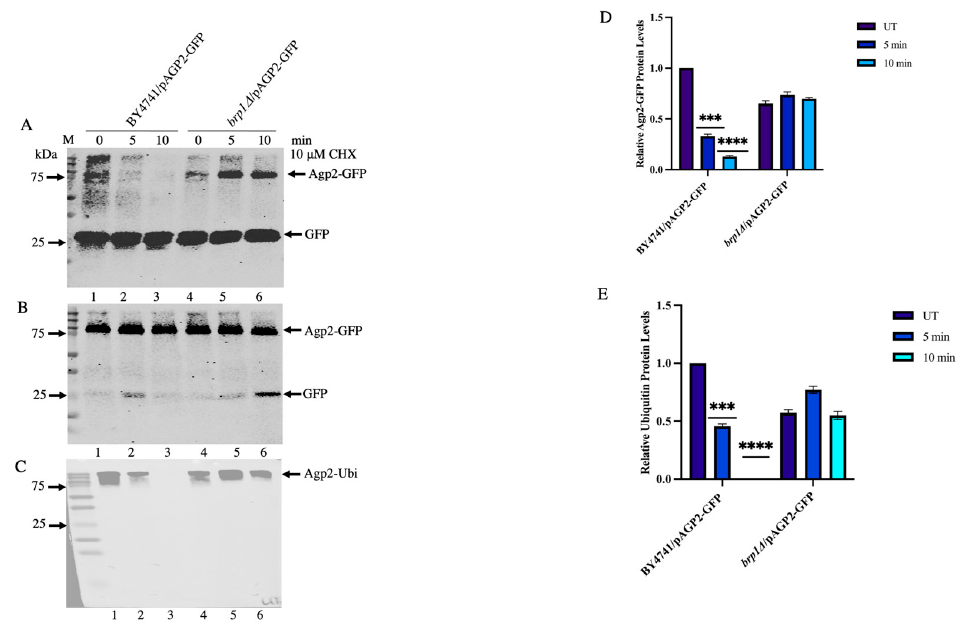
Figure 8. Analysis of immunoprecipitated Agp2-GFP from saturated cultures of the WT and the brp1 ∆ mutant. ( A ) Immunoprecipitation of Agp2-GFP showing its disappearance in the WT and not in the brp1 ∆ mutant following CHX treatment. Briefly, total extracts were prepared from saturated cultures treated with CHX, subjected to pull-down assay using anti-GFP magnetic beads and probed by immunoblot with anti-GFP antibodies. ( B ) Total cell extracts were used to monitor the input level of Agp2-GFP. ( C ) The same amount of the pull-down samples from panel ( A ) were analyzed by immunoblot probed with anti-ubiquitin antibodies. ( D , E ) Quantification of the relative level of the immunoprecipitated Agp2-GFP under the indicated conditions from panels ( A , C ), respectively. M, prestained protein markers in kDa. Error bars indicate S.E. The data are representative of three biological replicates and analyzed by 2-way Anova Test. *** Is equivalent to p -value < 0.001, **** Is equivalent to p -value < 0.0001